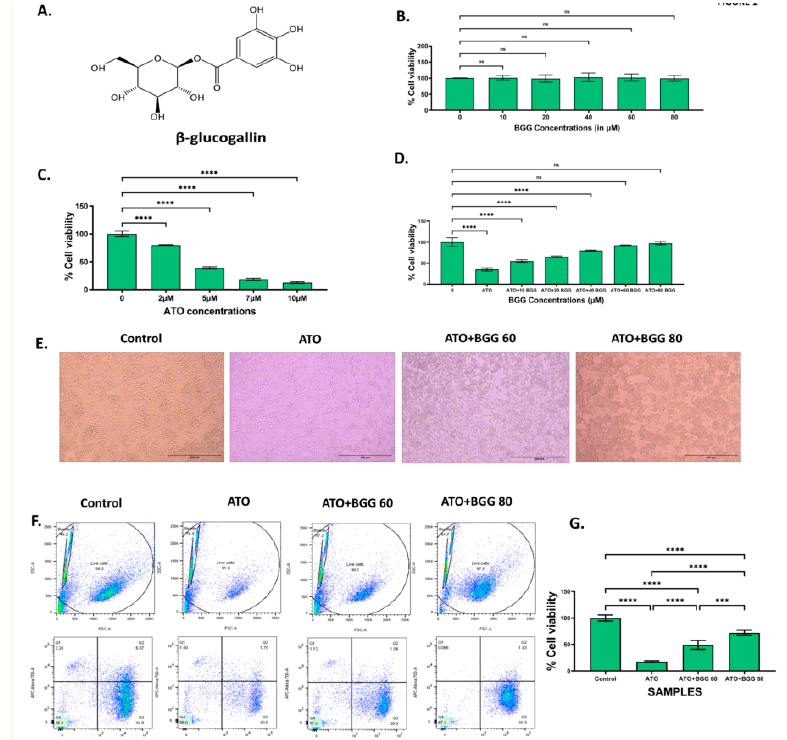
Figure 1. ( A ) β -glucogallin (BGG) chemical structure. ( B )% Cell viability of different concentrations of BGG on RAW 264.7 for 24 h measured by MTT assay. ( C ) % Cell viability of different concentrations of arsenic trioxide (ATO) on RAW 264.7 for 24 h measured by MTT assay. ( D ) Protection of RAW 264.7 cells by pre-treatment with BGG measured by MTT assay. Cells were pre- treated with different BGG concentrations for 1 h, followed by ATO (5 μ M) treatment for 23 h. ( E ) Cell images representing the morphology of RAW 264.7 cells, scale bar 200 μ m. ( F )% Cell viability measured by flow cytometry with Calcein-AM and PI. ( G ) Graph represents the percentage of cell viability, mean ± SD of two experiments. For ( B – D ) results are mentioned as mean ± SD ( n = 3), p - value ≤ 0.05 (*** p < 0.001, and **** p < 0.0001).ns=non-significant.